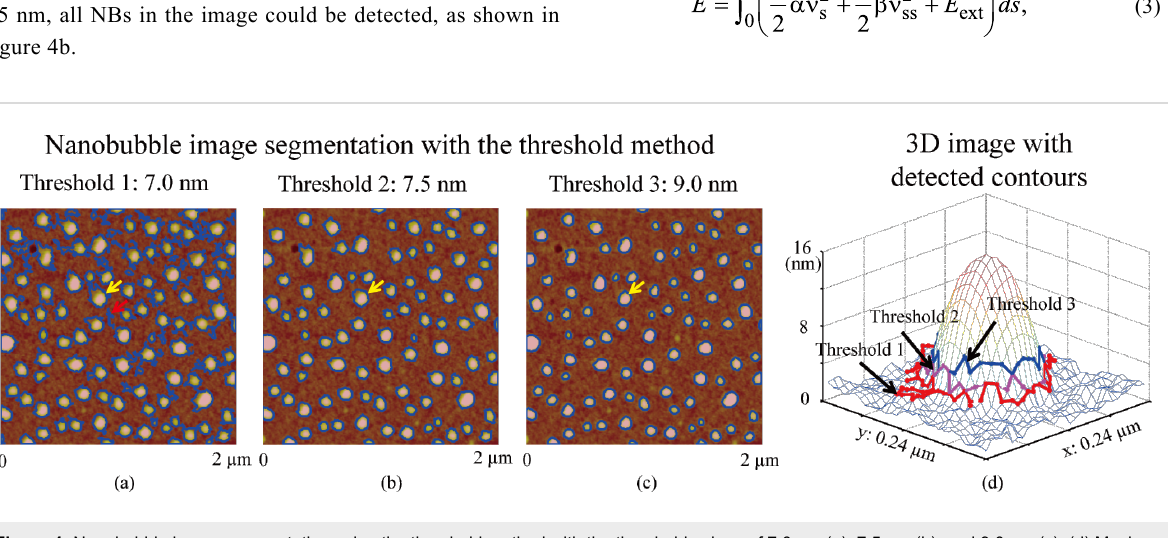
Figure 4: Nanobubble image segmentation using the threshold method with the threshold values of 7.0 nm (a), 7.5 nm (b), and 9.0 nm (c). (d) Mesh plot of a selected NB and the detected contours with the different threshold values. The detected boundaries are strongly related to the selected threshold